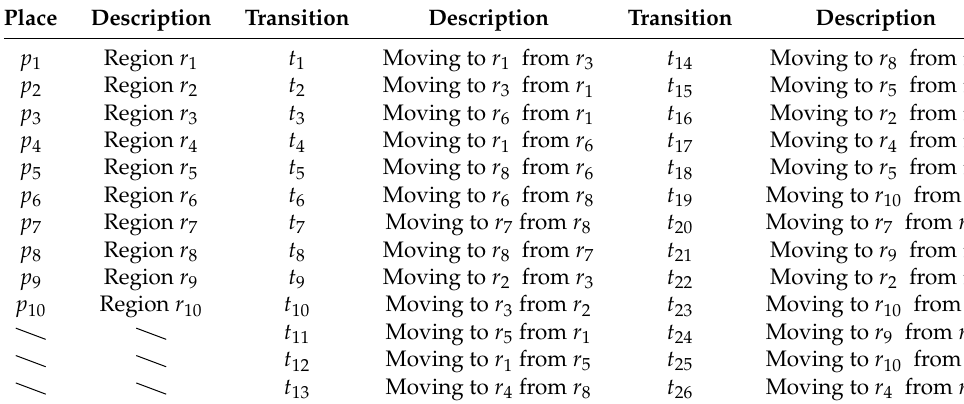
Figure 2. The TCPN system corresponding to the MTRS in Figure 1. Table 1. Description of places and transitions in Figure